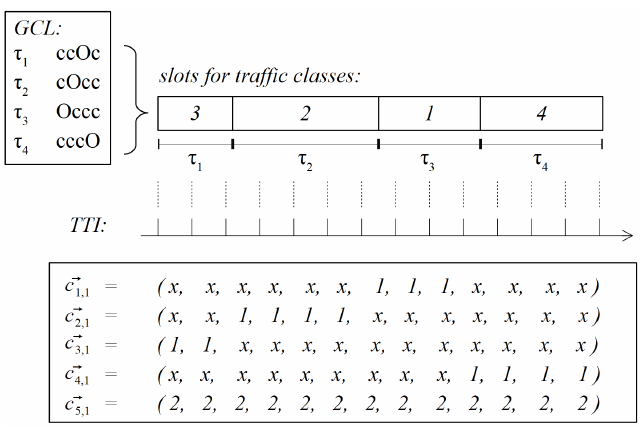
Figure 4. Example of the translation of a GCL into LCP vectors (cid:126) c i , j